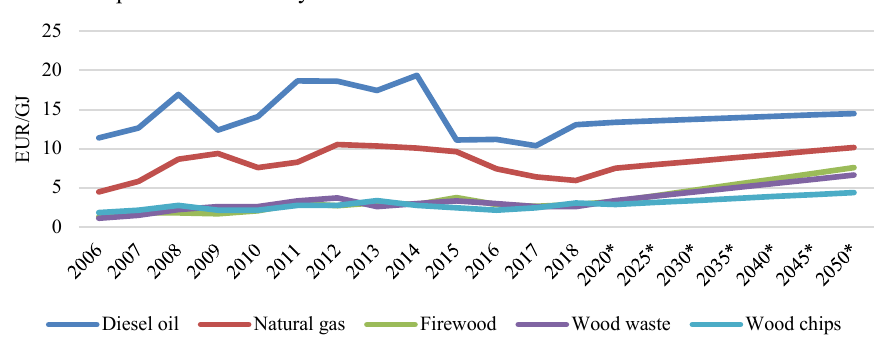
Fig. 3. Historical prices [31] and forecast of the main primary resources used in the industrial